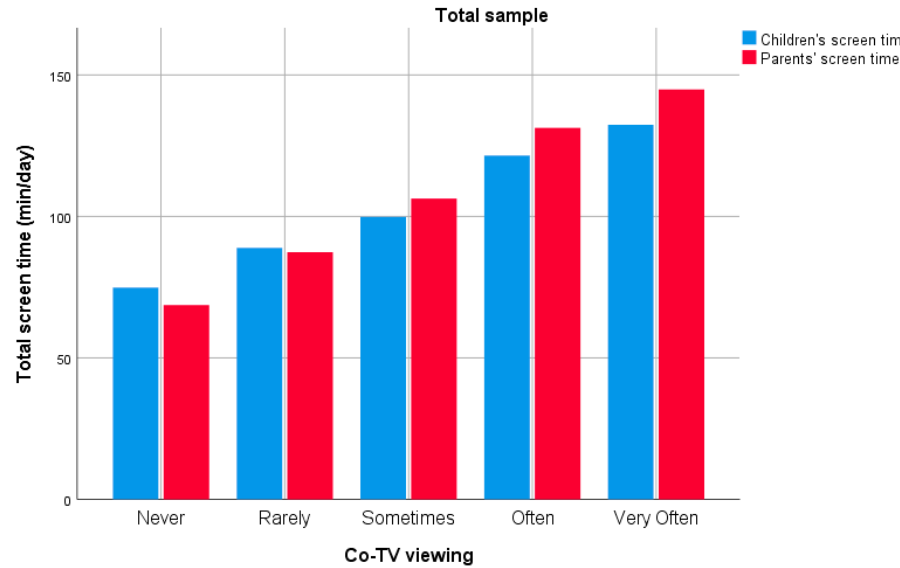
Figure 4. Graphical representation of the association between co-TV viewing and children’s (in blue) and parents’ (in red) screen time (min/day) for the total sample.